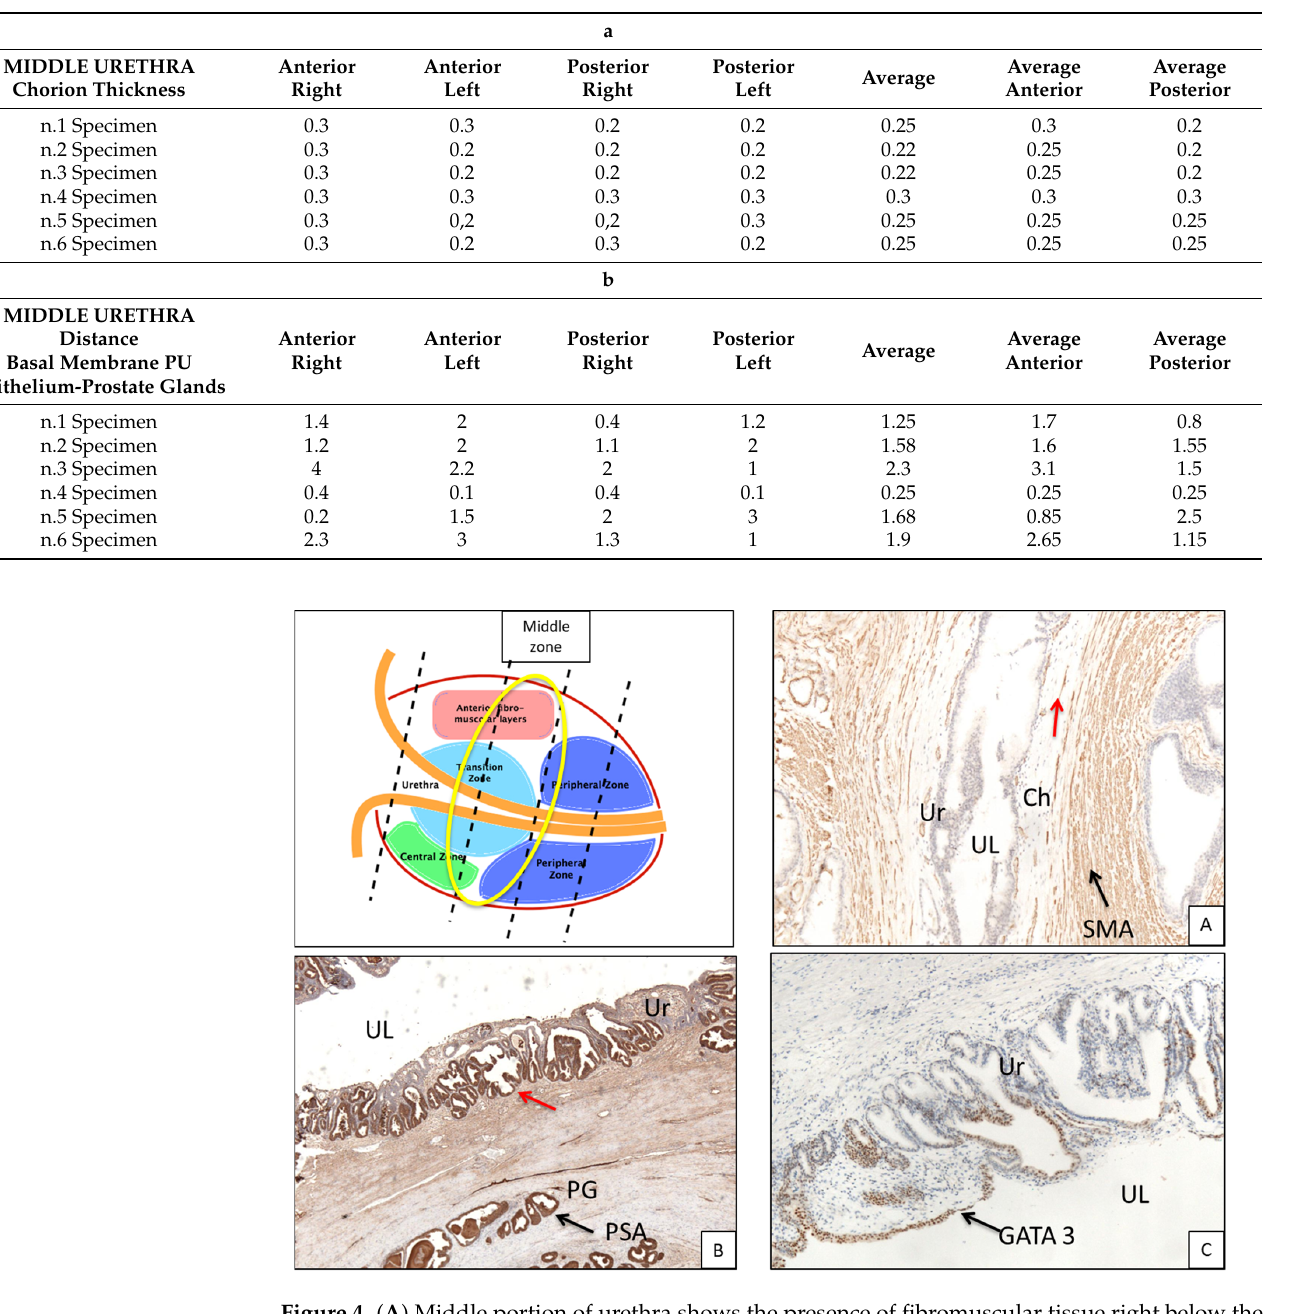
Table 3. a. Chorion thickness at the level of the middle PU. b. Distance between basal membrane of the PU epithelium and prostate glands at the level of the middle PU.